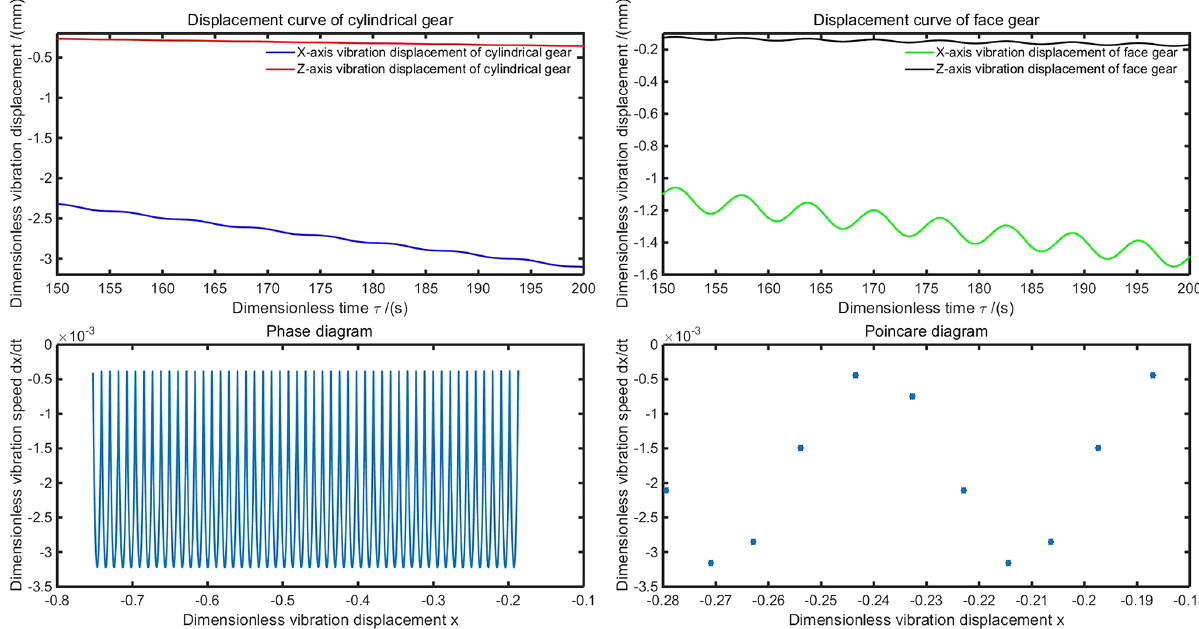
Figure 8. Displacement, phase, and Poincare diagrams of friction coefficient 0.5.